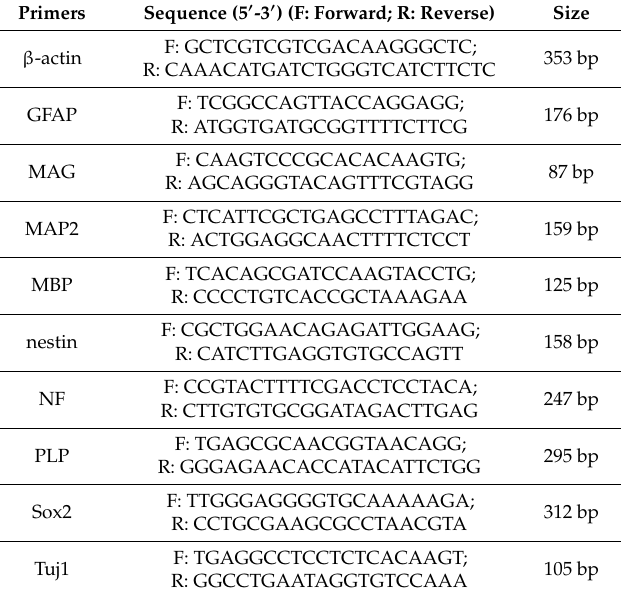
Table 1. List and sequence of mouse primers used for RT-PCR